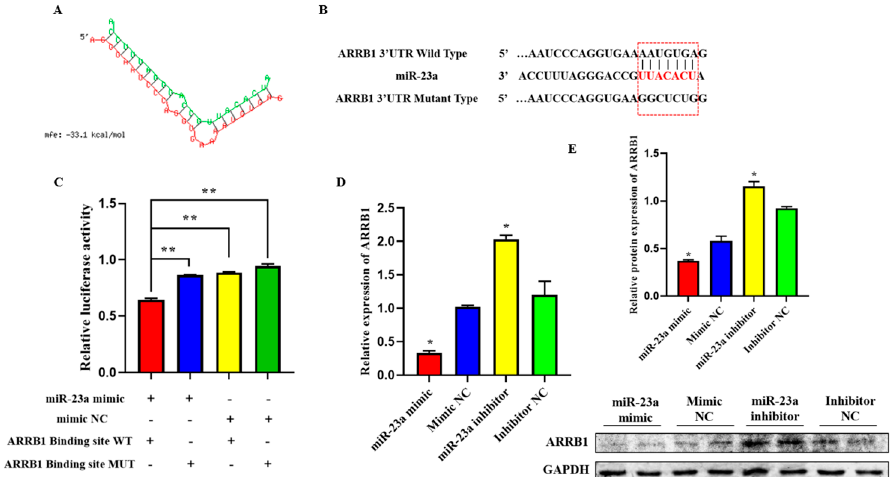
Figure 6. ARRB1 is a Target of miR-23a. ( A ) Predicted binding site between miR-23a and ARRB1 . ( B ) The predicted binding site and mutated site of miR-23a in the 3 (cid:48) UTR of ARRB1. ( C ) The pmirGLO-ARRB1-WT and pmirGLO-ARRB1-MUT plasmids were co-transfected with mi-23a mimics or NC into 293 T cells. Luciferase activity was determined 48 h post-transfection. ( D , E ) miR-23a repressed ARRB1 expression at both the mRNA and protein levels in adipocytes. * p < 0.05, ** p <